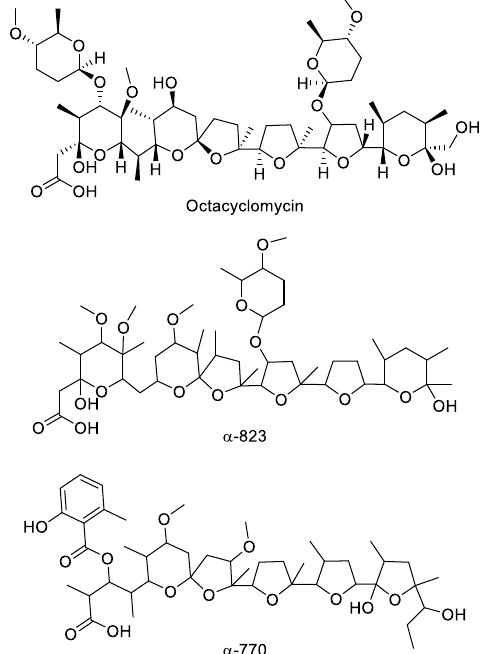
Figure 4. Chemical structure of polyethers produced by Actinoallomurus and described in Section 2.4.